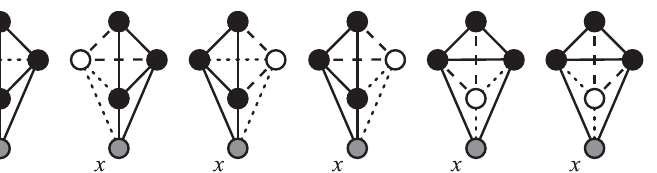
Fig 6. Symmetries and coefficients. The coefficientat o 70 in Eq (1) is 6 becauseeach inducedembedding of G * = G m (70) = G 28 in H is counted six times. First, there are three different choices for y (the white node), therefore each embeddingof G 28 results in three correspondingappearances of graphlet G 7 (solid edges) with x in orbit O 12 . For each occurrence, both extensions(dashededges)lead to x in orbit O 70